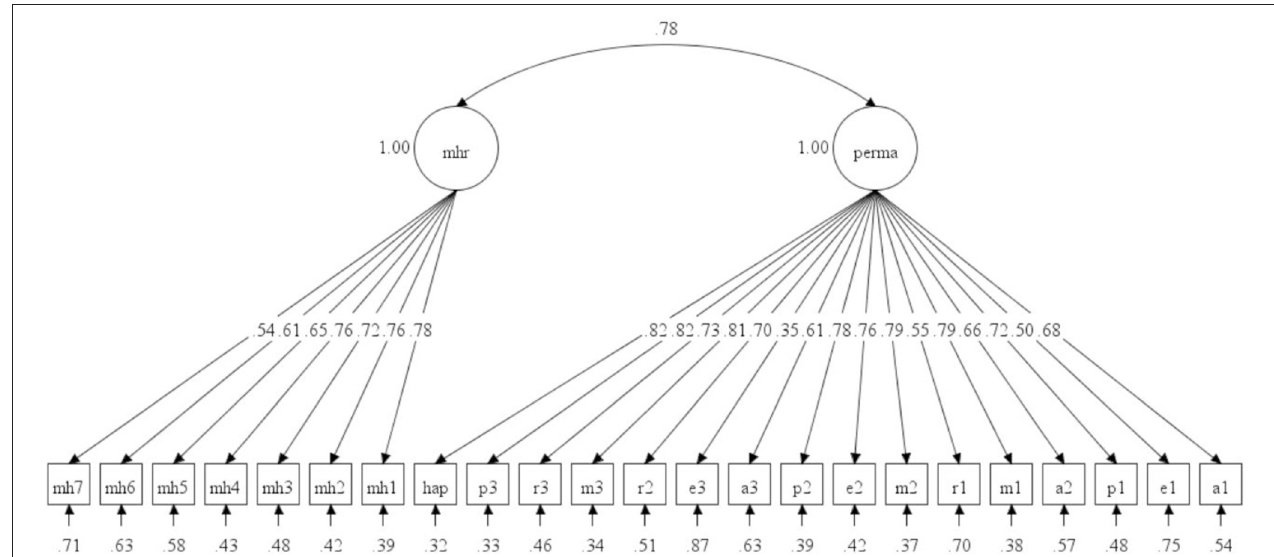
FIGURE 1 | Standardized solution for the two-factor model of PERMA and Mature Happiness. Error is not shown but it was specified for each variable. Error covariances were not allowed ( N =